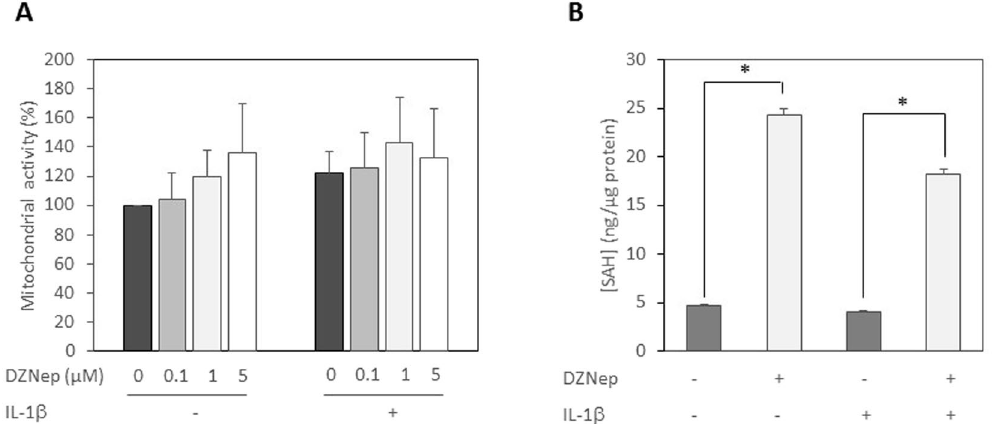
Figure 1. DZNep, a SAHH inhibitor, was not toxic in chondrocytes. ( A ) Primary chondrocytes were treated with DZNep (0 µ M, 0.1 µ M, 1 µ M or 5 µ M) in the presence or absence of IL-1 β (1 ng/mL) for 72 h. After treatment, cell viability was assessed by WST-1 assay. Data are expressed as means ± SEM. ( B ) Primary chondrocytes were treated or not with DZNep (1 µ M) in the presence of IL-1 β (1 ng/mL) for 72 h. After treatment, proteins were extracted, and SAH levels were determined in cells by ELISA assay. Data are expressed as means ± SEM. * p-value ≤